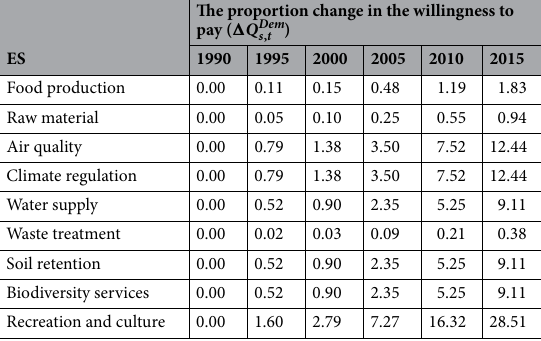
Table 3. Changes in the proportion of willingness to pay in Qinghai.